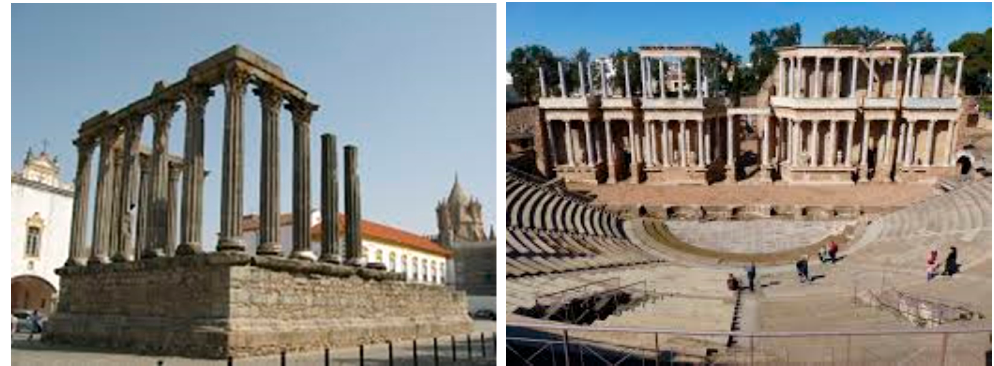
Figure 1. Roman Temple Évora ( left ); Roman theatre Mérida ( right